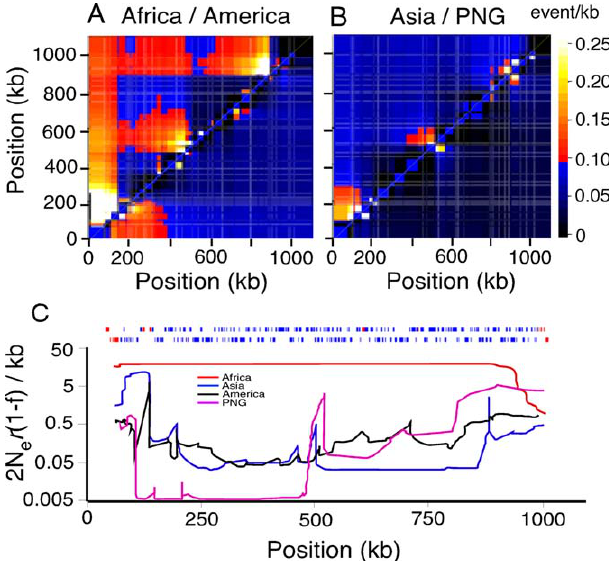
Figure 2. The Distribution of Detectable Recombination Events on Chromosome 3 of P. falciparum In (A) and (B), each panel shows, for two populations, a minimum number of recombination events (assuming an infinite-sites model) between each pair of segregating sites, scaled by physical distance to identify regions of high and low recombination. (A) African (upper) and American (lower) populations. (B) SE Asian (upper) and PNG (lower) populations. The color bar unit is recombination event/kb. (C) Estimates of population recombination rate variation for African (red line), SE Asian (blue), American (black), and PNG (purple) samples using the RJMCMC method with a jump penalty of five. Shown on top are the locations of genes on the plus (top) and minus (below) strands, with known cell-surface genes in red [34]. DOI: